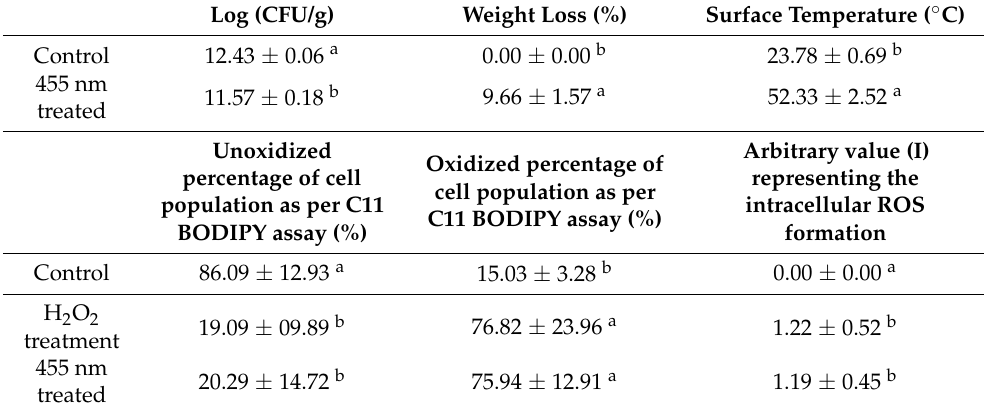
Table 3. Effect of the 455 nm LED treatment on the survival, weight, and surface temperature of low- a w S. Typhimurium ATCC13311. Flow cytometric quantification of membrane lipid oxidation using C11-BODIPY 581/591 dye and intracellular ROS generation using carboxy-H2DCFDA dye